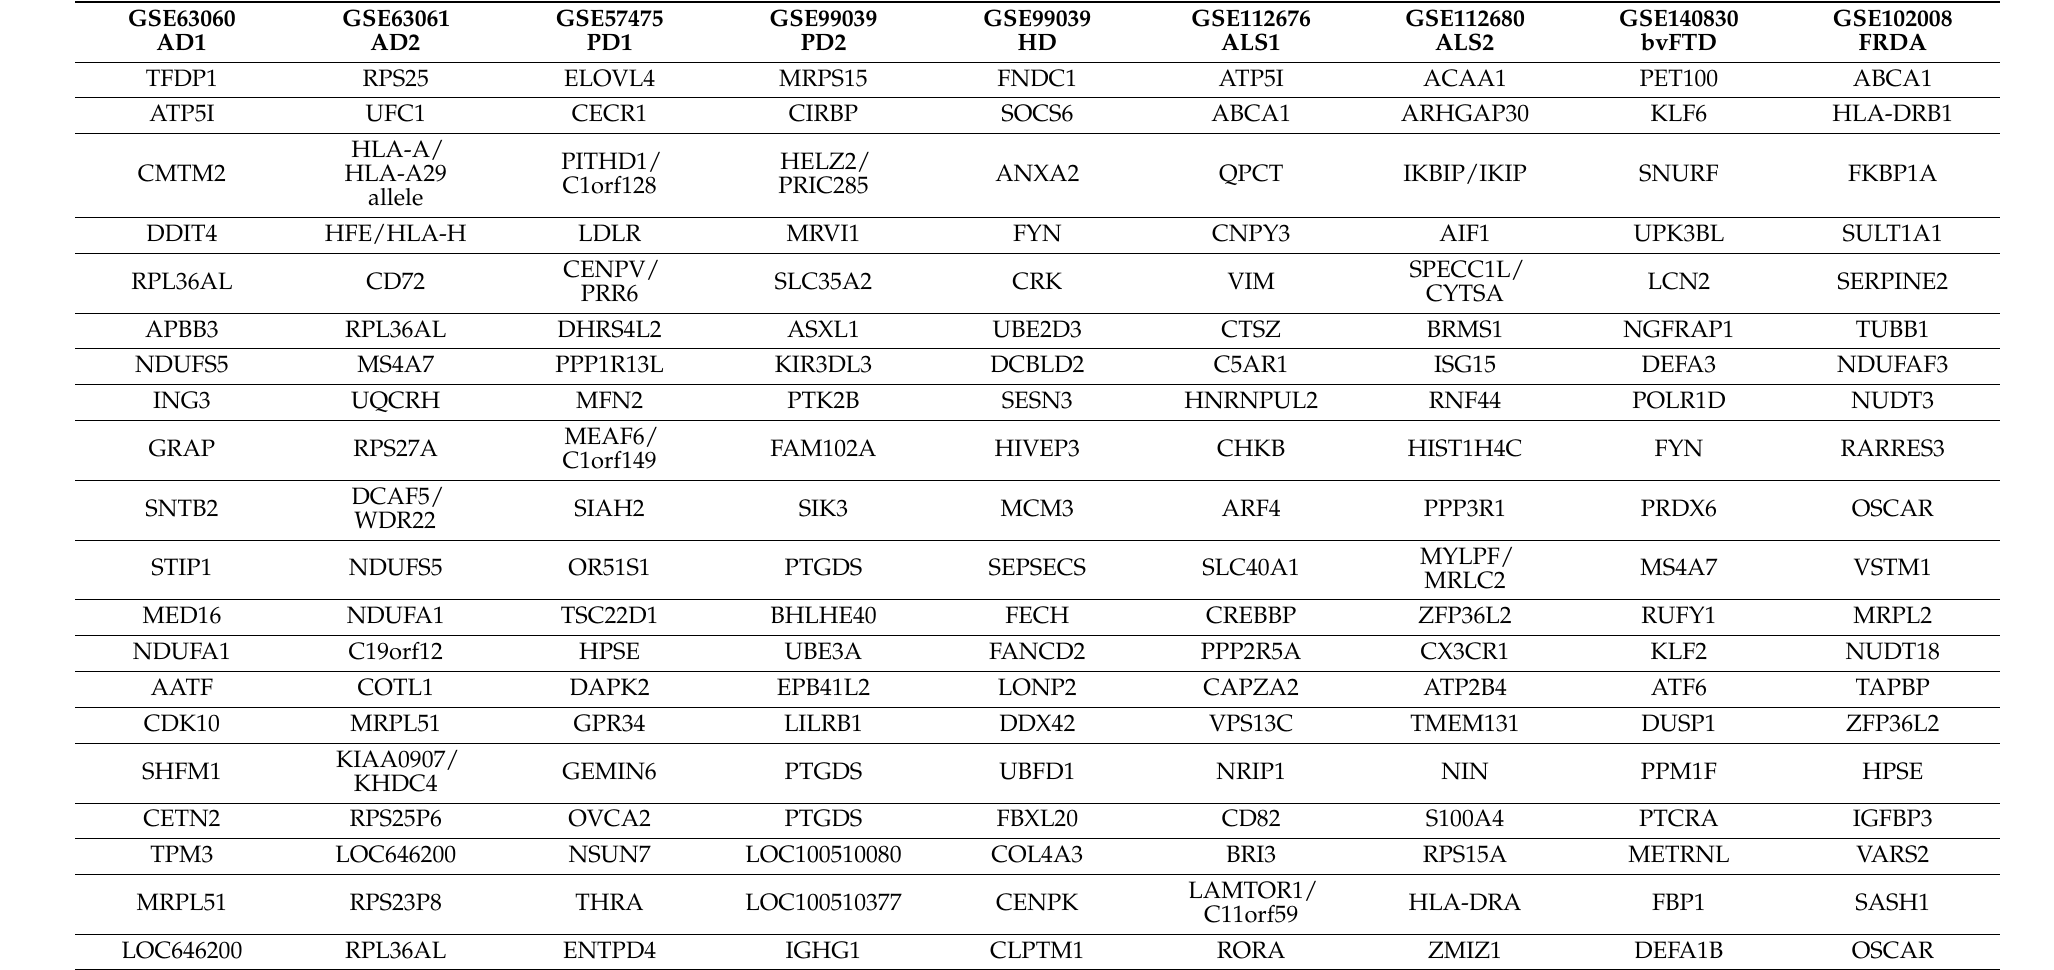
Table 2. Random Forest disease classifying transcript